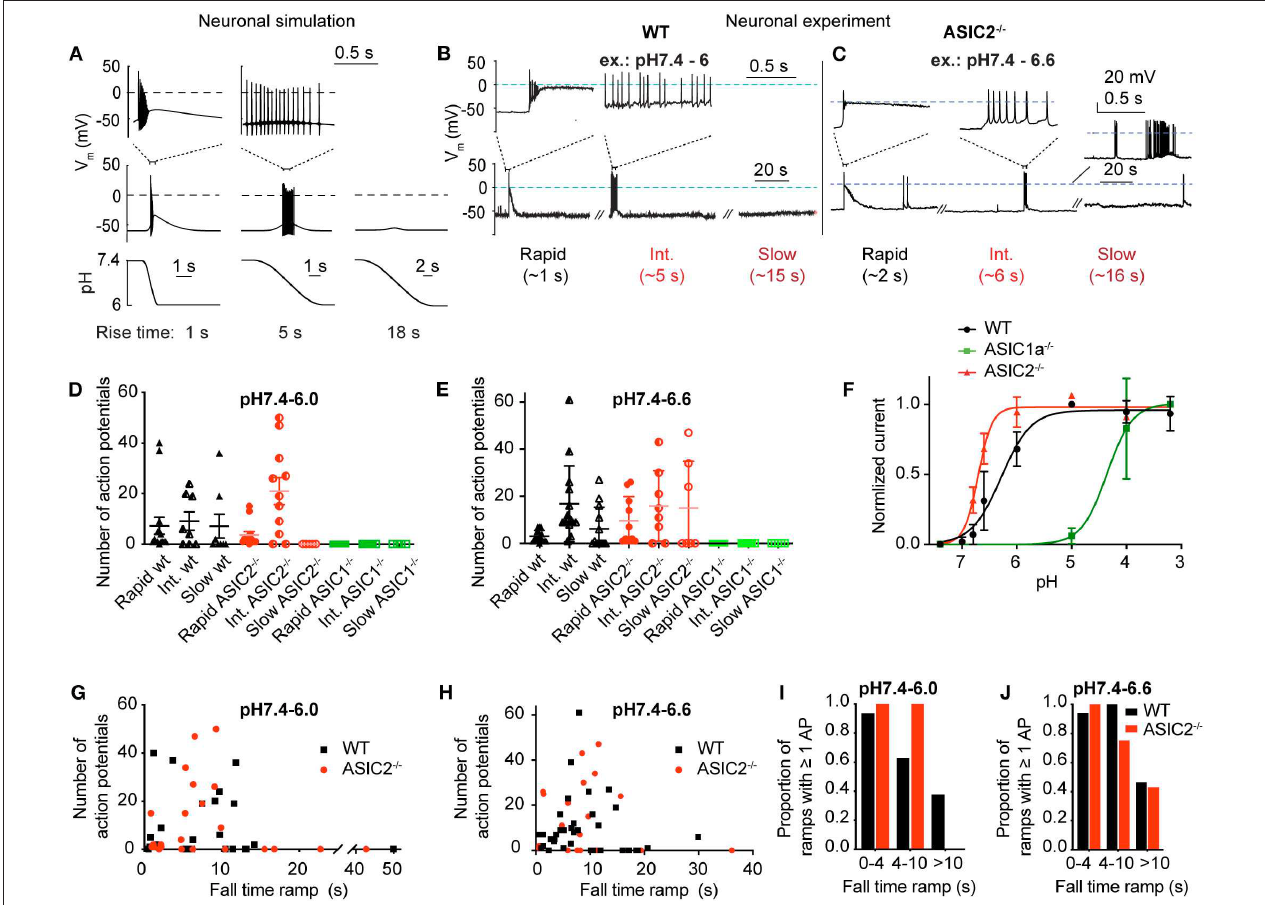
FIGURE 6 | Neuronal modeling and experiments in cortical neurons to assess the response to slow pH changes. (A) Simulated neuronal activity in response to pH 7.4–6.0 ramps using the Hodgkin-Huxley (HH) neuronal model in which the ASIC1a model was integrated. Membrane potential changes in response to the pH change (bottom panel) are shown in the middle panel; selected parts of the traces are shown in the top panel on an expanded time scale. (B,C) representative experiments with WT (pH 7.4–6.0 ramps) and ASIC2 − / − cortical neurons (pH 7.4–6.6 ramps) in current-clamp. Baseline current was injected to obtain a resting membrane potential close to − 60mV. For the slow pH ramp with ASIC2 − / − cortical neurons, one trace with practically no (bottom), and one with high activity (top) is shown. (D,E) Number of action potentials (APs) induced by rapid (ramp FT < 4s), intermediate (ramp FT = 4–10s) and slow (ramp FT > 10s) pH 7.4–6.0 ramps (D) or pH 7.4–6.6 ramps (E) of WT, ASIC1a − / − and ASIC2 − / − cortical neurons ( n = 4–15). (F) pH dependence of ASIC currents in WT, ASIC1a − / − and ASIC2 − / − cortical neurons. Currents were measured in whole-cell patch-clamp at − 60mV. Normalized current amplitudes are plotted, n = 2–10. The pH 50 values were 6.29 ± 0.23 (WT, n = 10) and 6.67 ± 0.03 (ASIC2 − / − , n = 4). For ASIC1a − / − neurons, the current amplitudes still increased between pH 4.0 and 3.2, and the pH 50 is therefore ≤ 4.10 ± 0.04 ( n = 2). (G,H) Number of APs of WT and ASIC2 − / − cortical neurons, plotted as a function of the pH ramp FT, in pH 7.4–6.0 ramps ( G , n = 23–28) and pH 7.4–6.6 ramps ( H , n = 23–36). (I,J) Proportion of pH 7.4–6.0 (I) or pH 7.4–6.6 ramps (J) that induced at least 1 AP, presented as probability ( n =